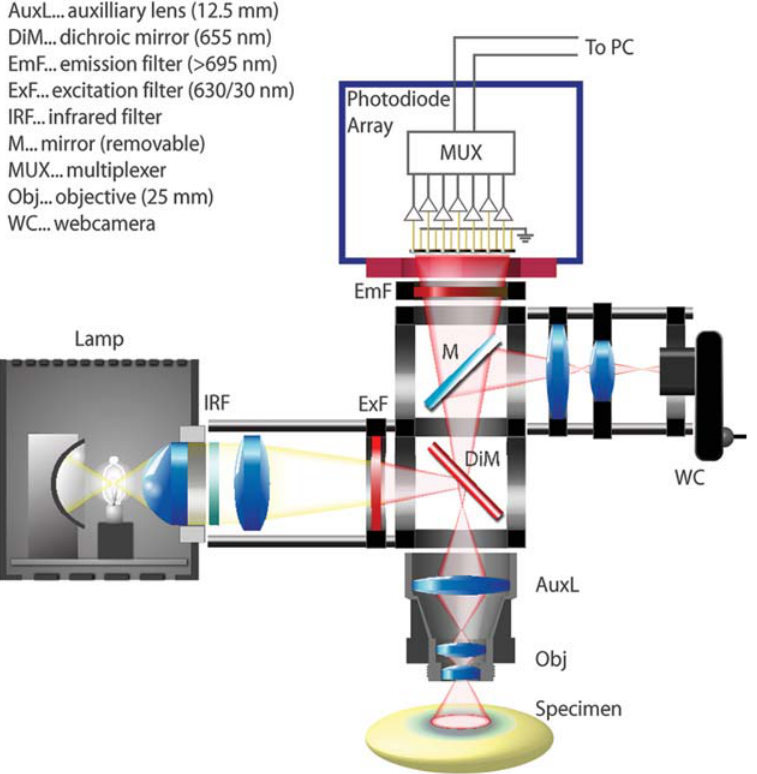
Figure 1. Schematic of the voltage-sensitive dye imaging apparatus. Affordable optical components can be assembled with standard mountings to build a macroscope with high numerical aperture. The use of large numerical aperture optics and high-quality filters allows recording with high signal-to-noise ratio in single trials. Since the photodiode array itself has insufficient spatial resolution for micrography and focusing, an equifocal web camera is also incorporated in the setup.